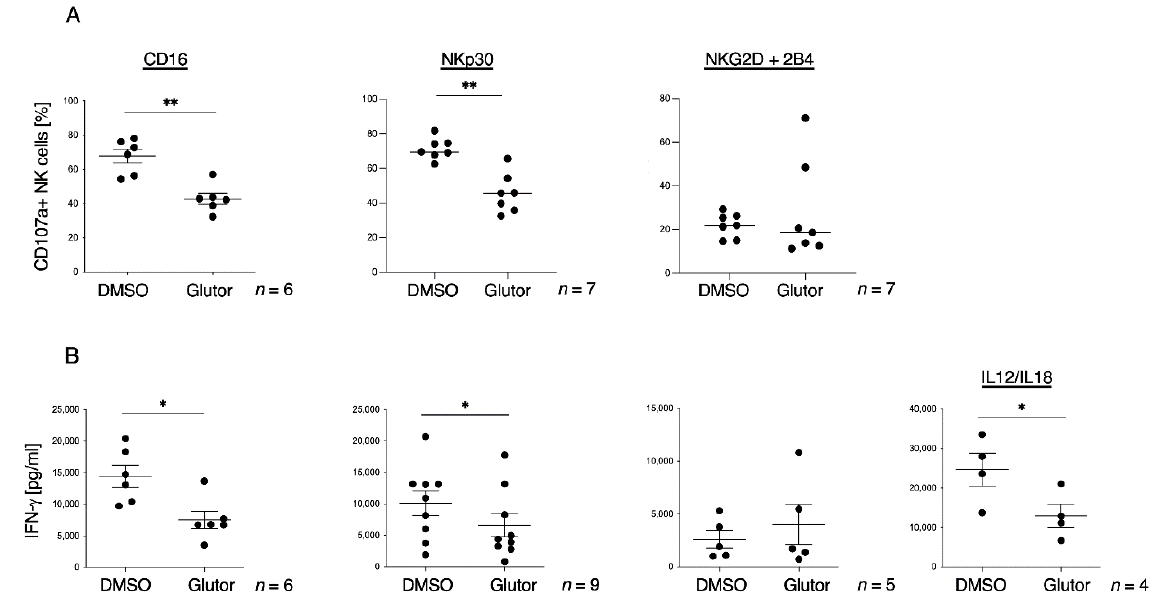
Figure 6. NK cell functions are significantly diminished after long-term inhibition of glucose transporter. ( A ) The 0.1 × 10 6 long-term treated NK cells (100 nM Glutor or 0.1% DMSO) were stimulated via plate-bound antibodies against CD16, NKp30 or NKG2D + 2B4 for 2 h in the presence of an anti-CD107a antibody (PE-Cy5) in the continued presence of Glutor or DMSO followed by analysis of degranulation via flow cytometry: n = 6–7. Data were pooled from six or seven independent experiments and each experiment was performed with one donor. ( B ) The 0.1 × 10 6 long-term treated NK cells (100 nM Glutor or 0.1% DMSO) were stimulated via plate-bound antibodies against CD16, NKp30 or NKG2D + 2B4 or via IL-12 + IL-18 for 16 h in the continued presence of Glutor or DMSO and IFN- γ secretion was measured (IFN- γ ELISA): n = 4–9. Mean with SEM. Data were pooled from